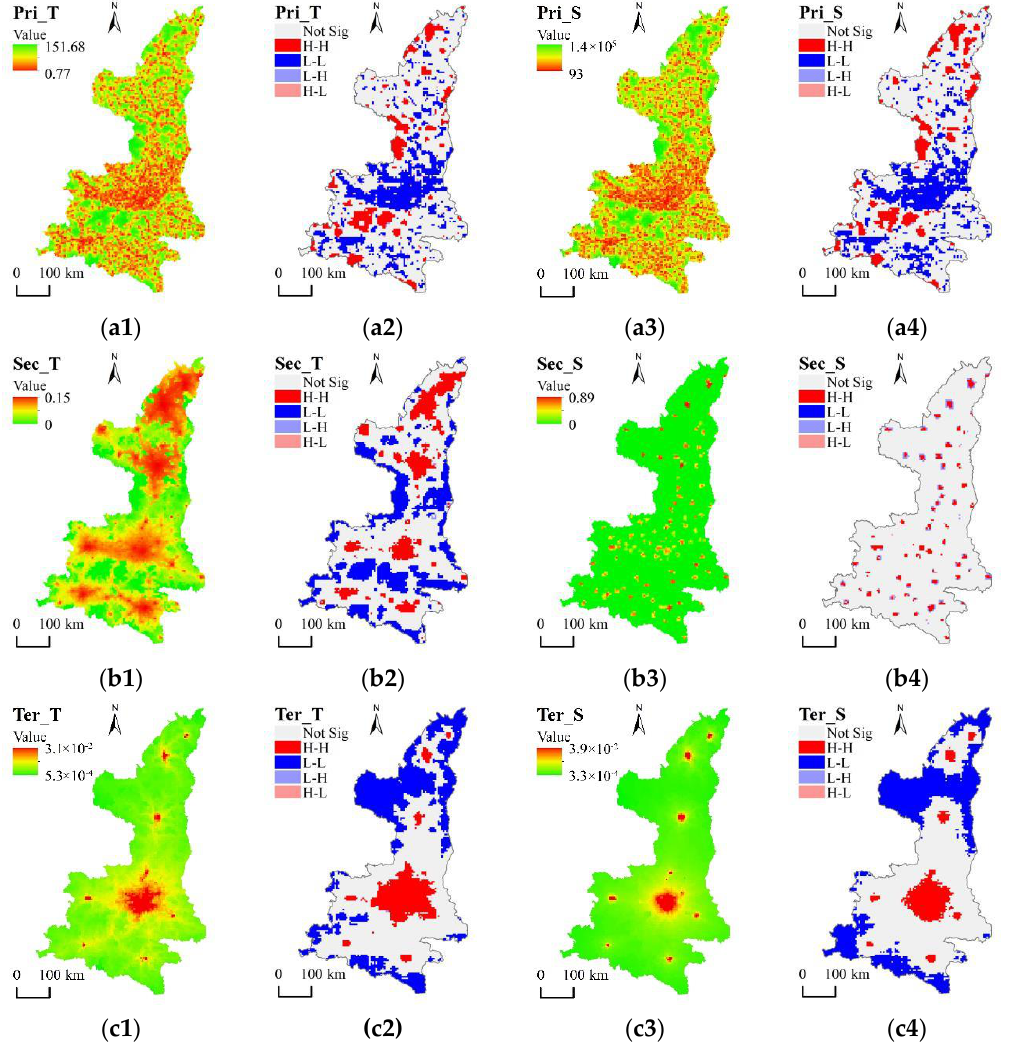
Figure 4. Accessibility to ( a1 , a3 ) primary medical services (Pri_T, Pri_S); ( b1 , b3 ) secondary medical services (Sec_T, Sec_S); ( c1 , c3 ) tertiary medical services (Ter_T, Ter_S); and LISA spatial cluster of ( a2 , a4 ) Pri_T and Pri_S; ( b2 , b4 ) Sec_T and Sec_S; ( c2 , c4 ) Ter_T and Ter_S in Shaanxi. Notes: Red areas represent high level of accessibility to three-level medical services and green areas represent low level of accessibility in ( a1 , a3 , b1 , b3 , c1 , c3 ).